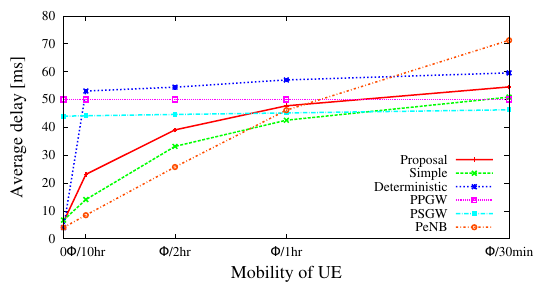
Figure 11: Average delay in Scenario 1 ( ρ = 0 . 5 )